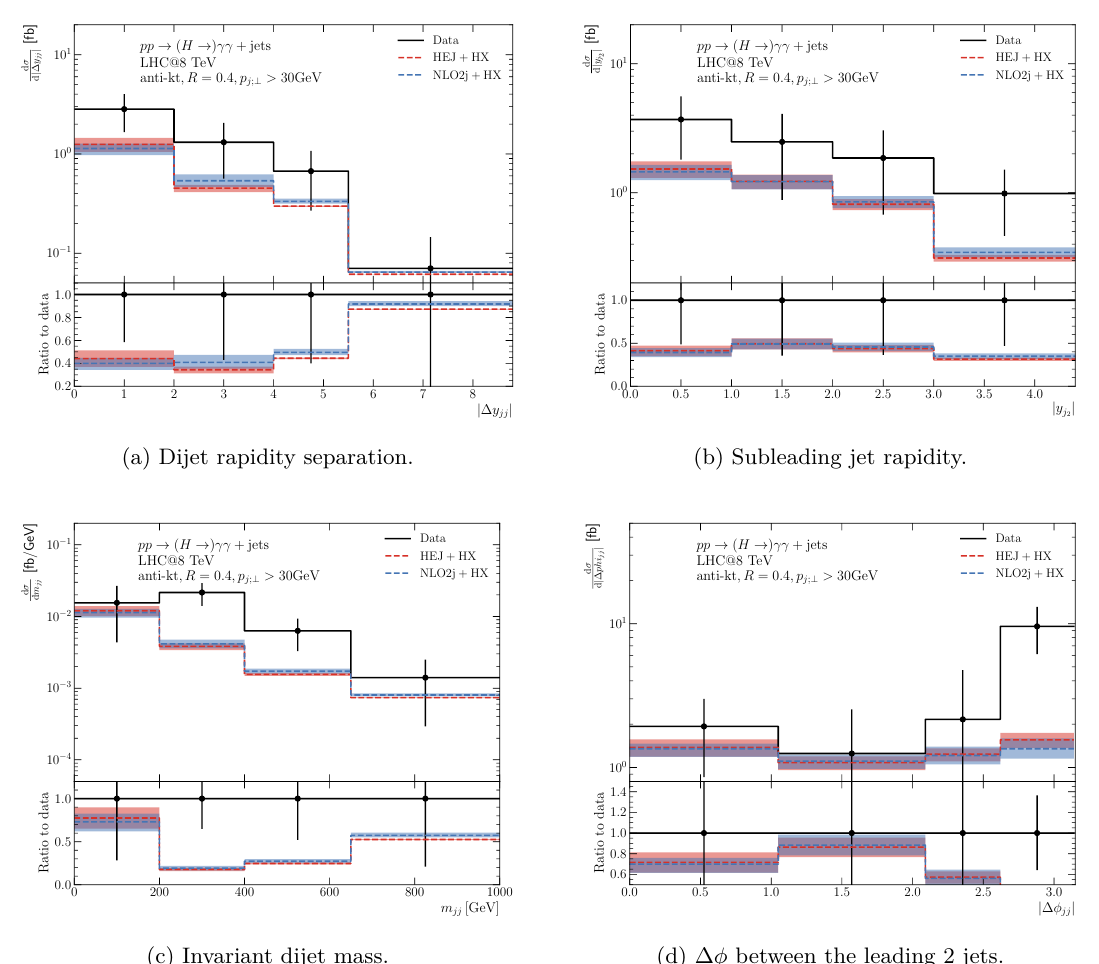
Figure 10. (a): dijet rapidity separation. (b): subleading jet rapidity. (c): dijet invariant mass. (d): azimuthal angle difference between the leading 2 jets. All 2-jet HEJ predictions are rescaled by the inclusive cross section ratio σ NLO2J /σ . The “HX” component is extracted from [33]. HEJ 2J